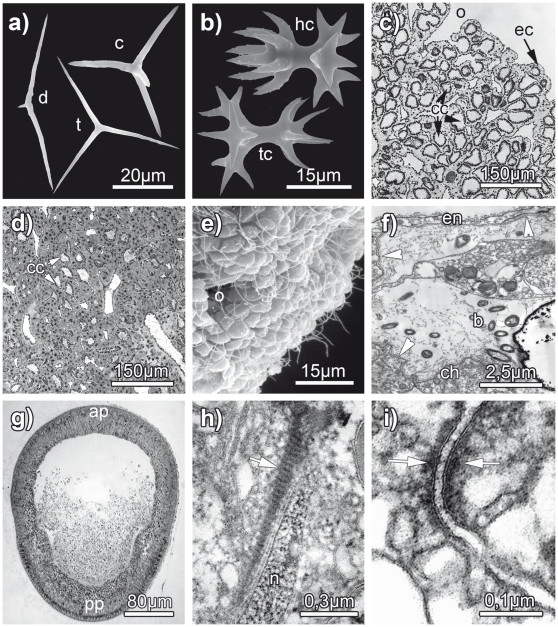
A few relevant morphological characters in the Homoscleromorpha.(a, b) spicules of the Homoscleromorpha (SEM). (a): c - calthrop of Plakina trilopha (Marseilles, Mediterranean); d – diod of Plakina trilopha (Marseilles, Mediterranean); t – triod of Plakortis simplex (Marseilles, Mediterranean); (b): hc – heterolophose calthrop (candelabra) of Corticium candelabrum (Adriatic Sea); tc – tetralophose calthrop of Plakina weinbergi (Mediterranean, Lebanon). (c) – Oscarella kamchatkensis (Avacha Bay, Bering Sea, Russia), transverse semi-thin section showing the sylleibid aquiferous system with eurypylous choanocyte chambers (cc), fine ectosome (ec) and an ostium (o); (d) – Pseudocorticium jarrei (Marseilles, Mediterranean) transverse semi-thin section showing the leuconoid aquiferous system with diplodal choanocyte chambers (cc). (e) – Oscarella malakhovi (Japan Sea, Russia) SEM micrograph of the flagellated exopinacoderm with ostium (o). (f) – Oscarella viridis (Marseilles, Mediterranean) TEM micrograph showing basement membrane (arrow heads) underlining the endopinacocytes (en) and choanocytes (ch) and endobiotic bacteria (b) in the mesohyl. (g) – Corticium candelabrum (Marseilles, Mediterranean) transverse semi-thin section of cinctoblastula larva, showing anterior (ap) and posterior (pp) poles. (h) – Plakina trilopha TEM micrograph of the cross-striated ciliar rootlet (arrow) close to a nucleus (n) in cinctoblastula larva. (i) – Oscarella microlobata (Marseilles, Mediterranean) TEM micrograph of cell junctions (zonula adhaerens) between the ciliated cells of cinctoblastula larva (arrows).